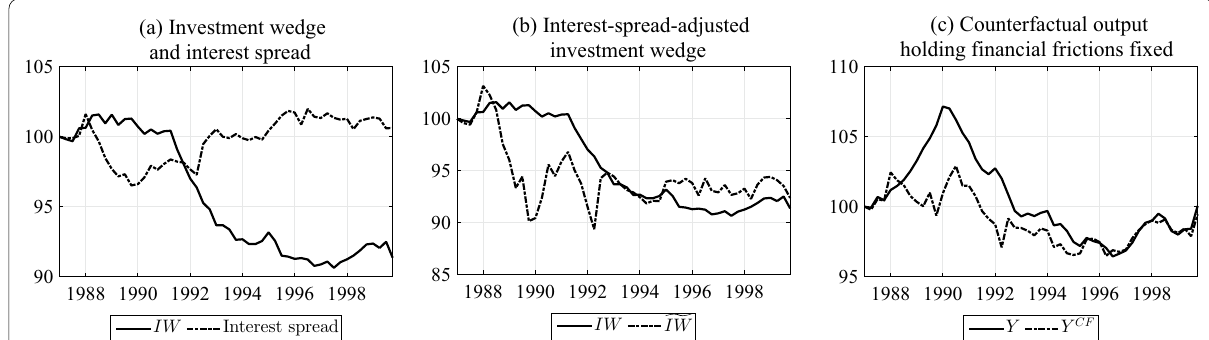
Fig. 24 Robustness: The role of disruptions in financial intermediation for σ ω = 0.10 (1987Q1–1999Q4). IW denotes the investment wedge, the interest spread corresponds to the spread between the lending and deposit rates obtained from the IMF International Financial Statistics, and is the interest-spread-adjusted investment wedge. Y is output and Y CF denotes the counterfactual path of output when holding financial frictions